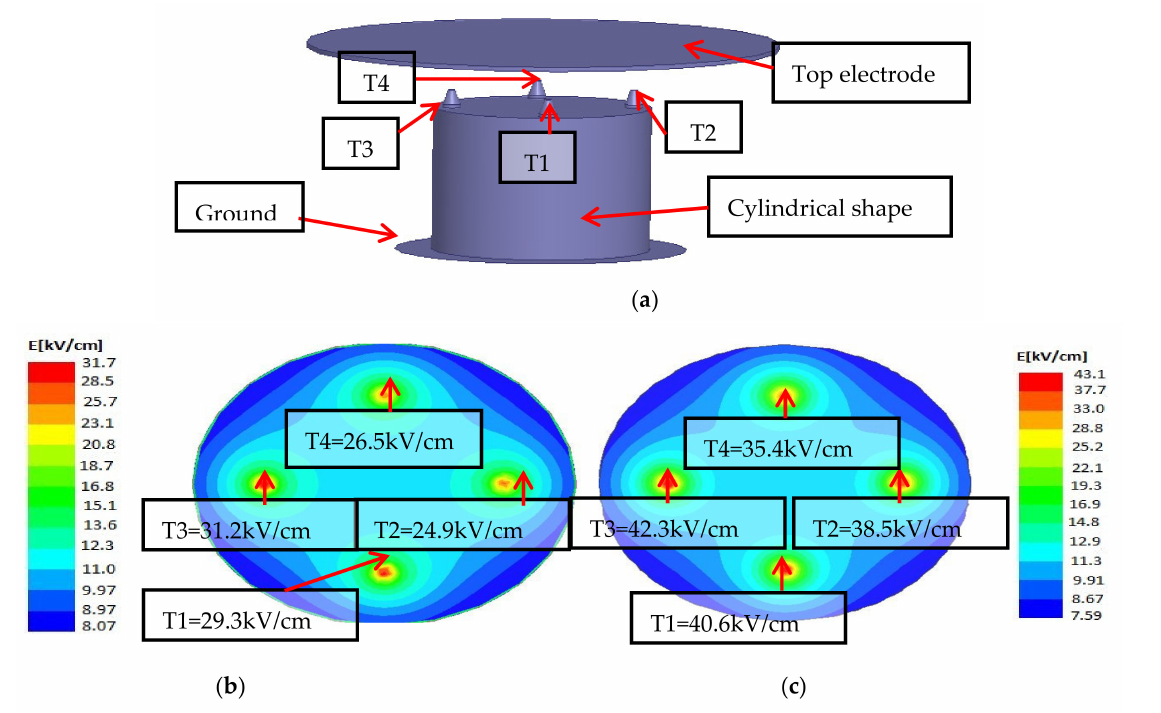
Figure 14. Probability of lightning on a cylindrical model: ( a ) circular shape, ( b ) field plot without upward leaders, ( c ) field plot with upward leaders.